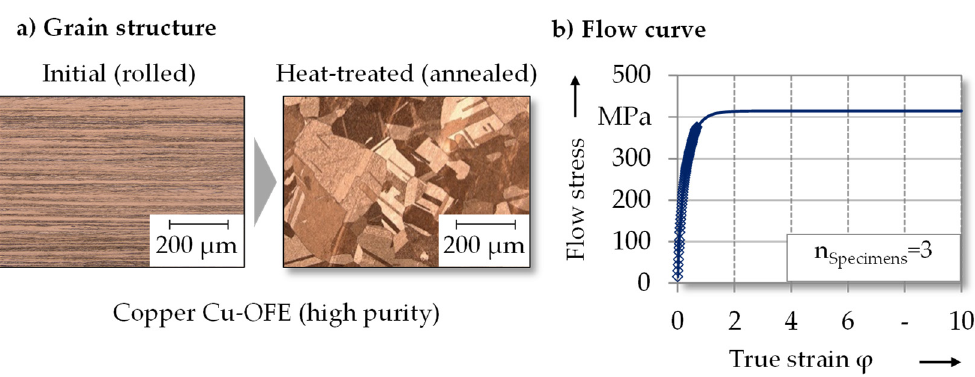
Figure 2. ( a ) Grain structure and ( b ) flow curve determined by tensile tests 0° to the rolling direction and extrapolated with the Hockett-Sherby approach.